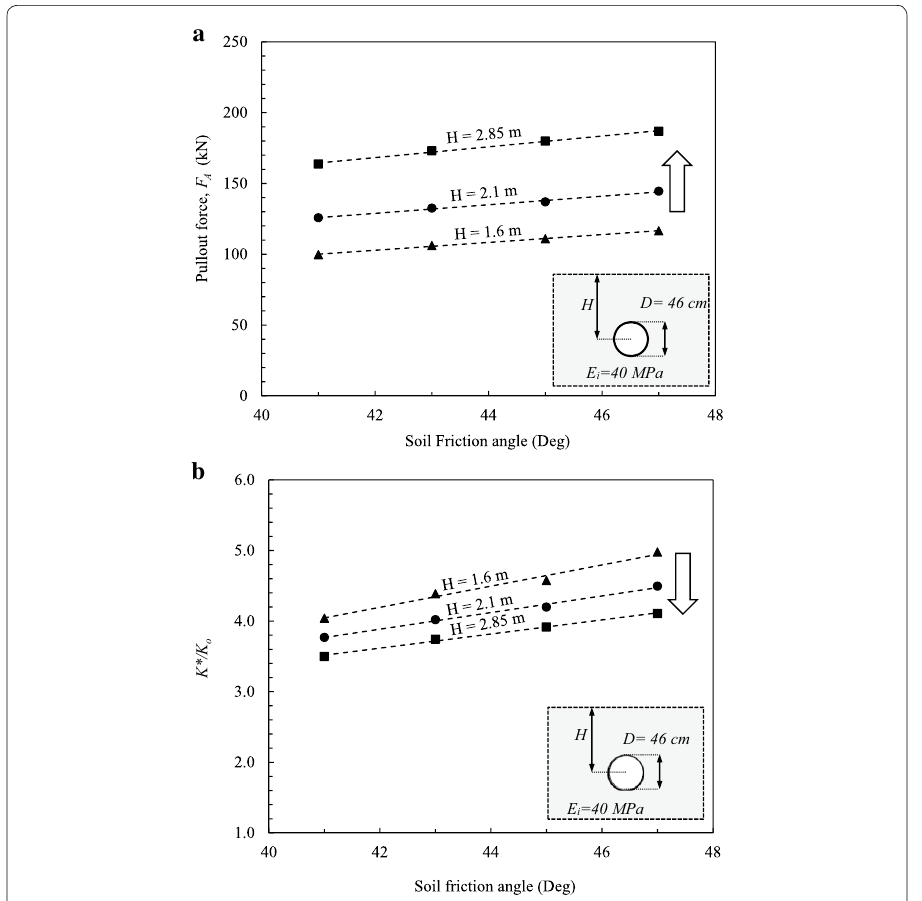
Fig. 8 Effect of friction angle a pullout force; b modified earth pressure